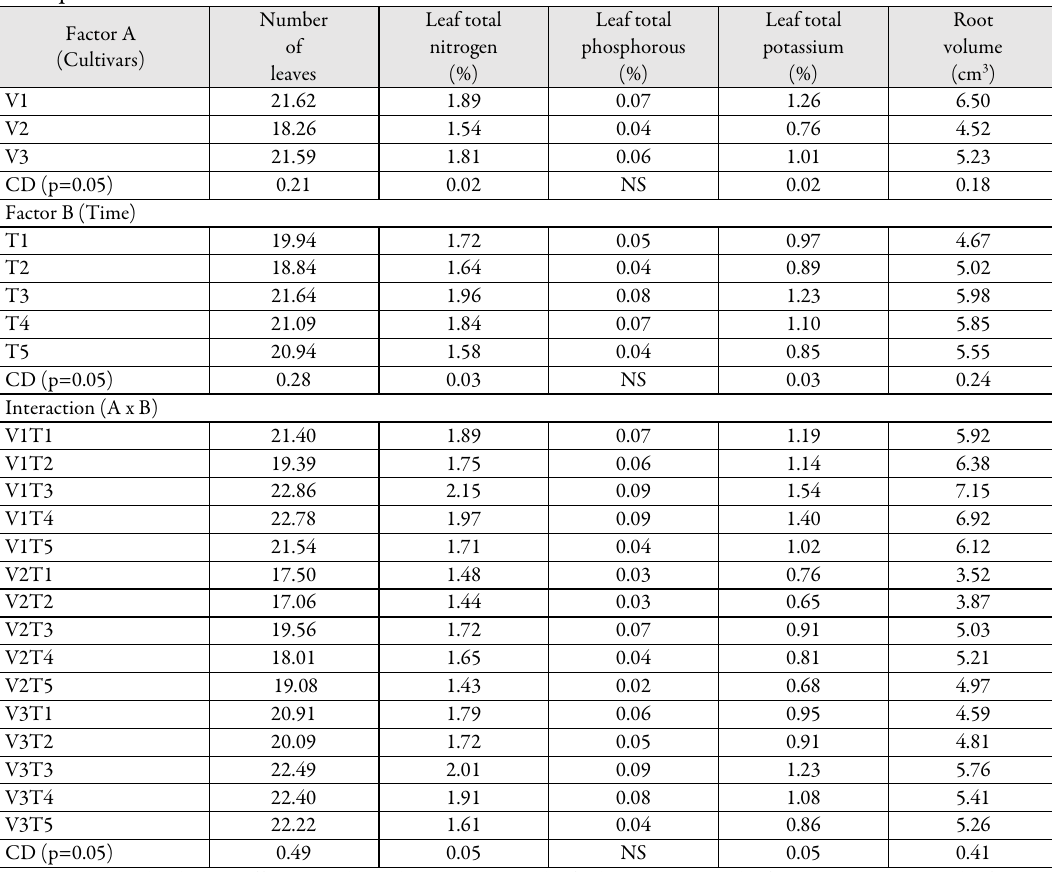
Table 2. Effect of sweet orange cultivars and time of budding on buddling leaf and root